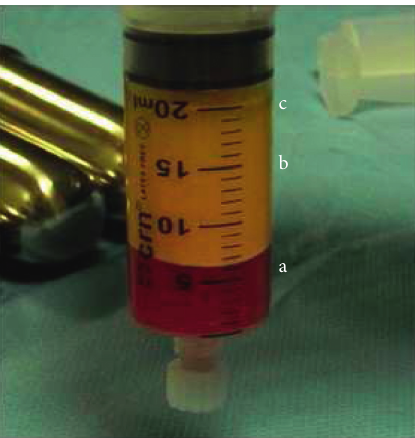
Figure 6: Centrifuged adipose tissue extract. From bottom to top: (a) First layer of blood and local anesthetics, (b) Second layer of fatty tissue, and (c) Third layer of lipids